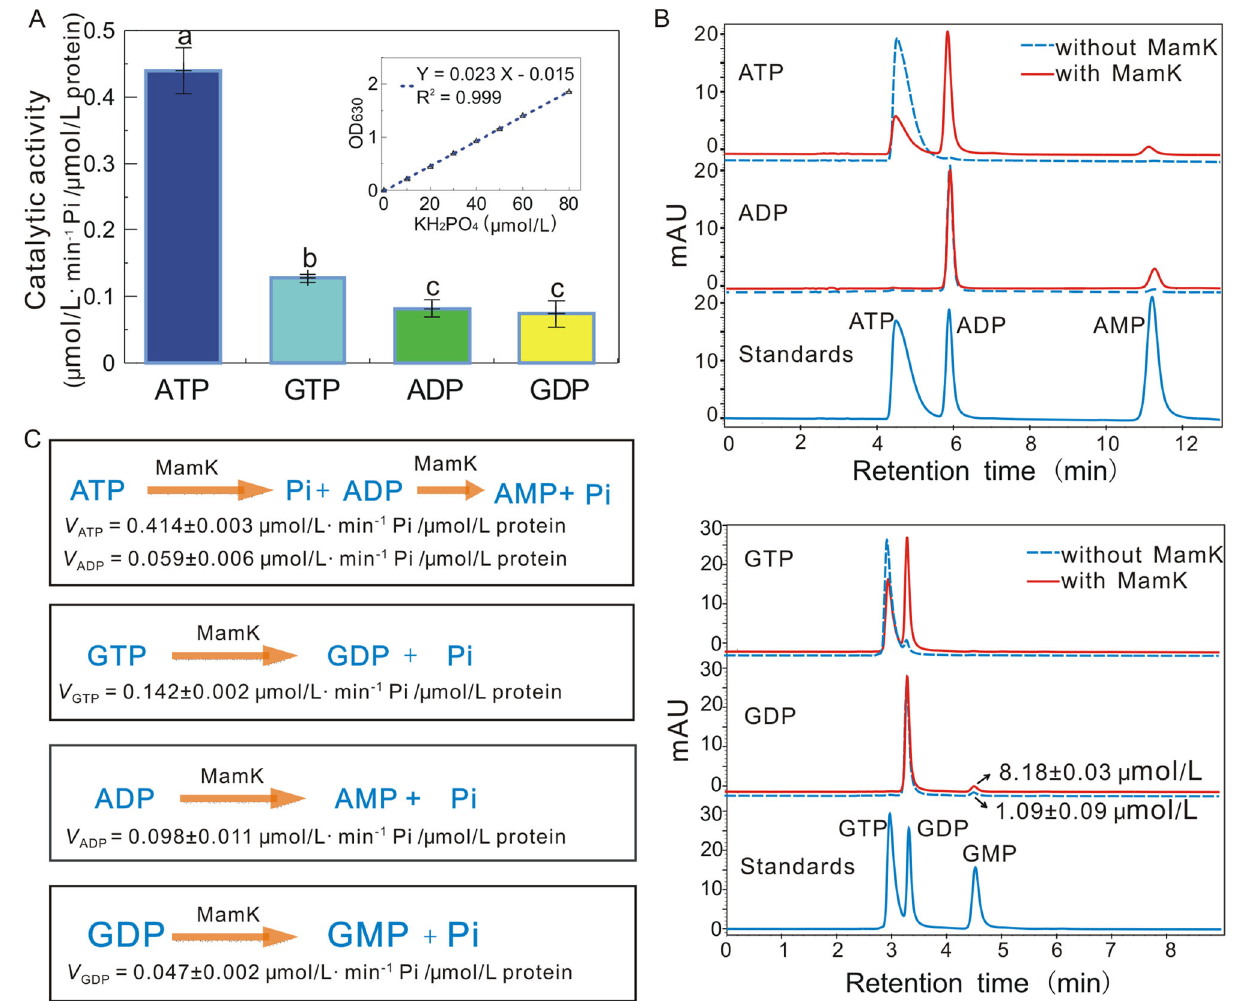
Figure 2. Catalytic ef fi ciencies and reaction processes of MamK towards various nucleotide states. (A) Various NTPase and NDPase activities were assayed based on phosphate release. The inset shows the KH 2 PO 4 standard curve from 0 to 80 μ mol/L. MamK hydrolyzed ATP, GTP, ADP and GDP and showed the highest catalytic activity towards ATP. Results are given as the mean ± SD ( n = 3). Different letters indicate signi fi cant differences among various nucleotide substrates (Duncan ’ s multiple range test, P < 0.05). (B) HPLC detection of the products formed from the hydrolysis of different nucleotide substrates by MamK. As a negative control, the reaction mixture was incubated under identical conditions, but in the absence of the MamK protein. ATP, ADP AMP, GTP, GDP and GMP were used as standards. (C) Catalytic reaction of MamK NTPases and NDPases. MamK catalyzed the formation of NDP and NMP from NTP and NDP,